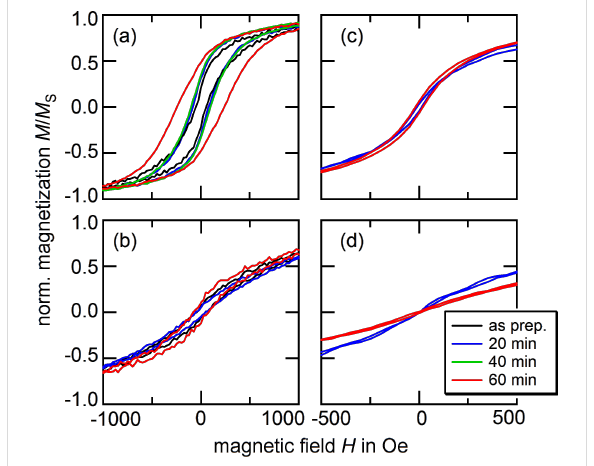
Figure 2: AGM measurements of nanoparticles assembled in mono- layers after different exposure times to a hydrogen plasma. The results were obtained at room temperature. (a) and (b) show the behavior of particle species I for in-plane and out-of-plane external fields; (c) and (d) are the respective results for species